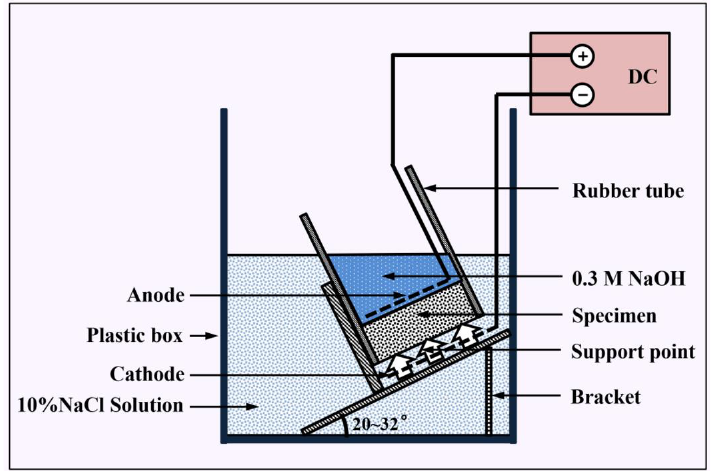
Figure 5. Schematic of RCM test setup. An isothermal conduction calorimeter was used for hydration heat test. The test time lasted 72 h and the temperature kept at 20 ◦